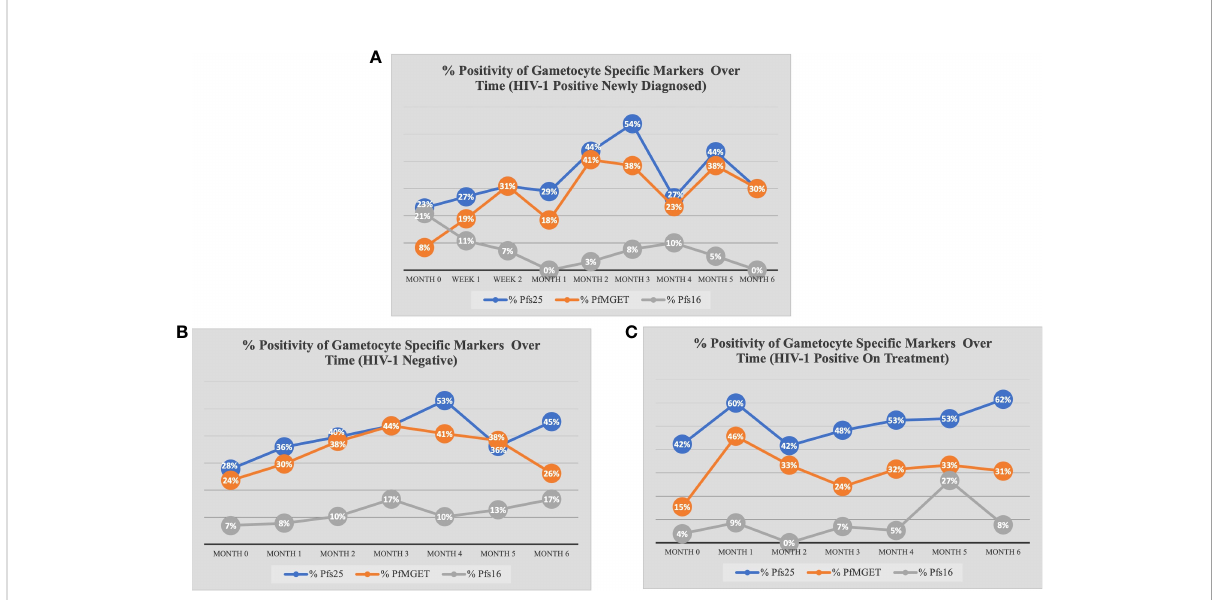
FIGURE 4 Percent Positivity of Each Gametocyte-Speci fi c Marker Over Time for Each Study Group. The prevalence of each gametocyte-speci fi c transcript biomarker (as a percentage of total analyzed) at each time point for (A) HIV-1 positive newly diagnosed volunteers (B) HIV-1 negative volunteers and (C) HIV-1 positive volunteers on